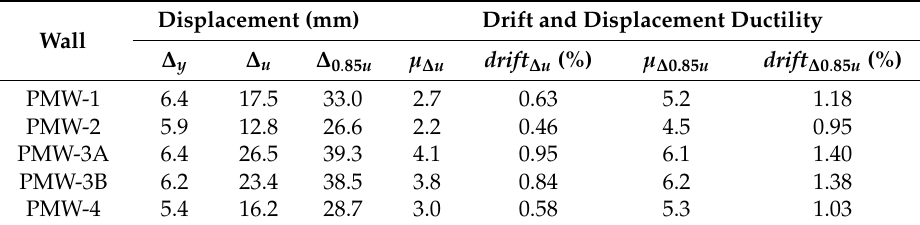
Figure 10. Theoretical yielding point of the test walls. Table 3. Summary of displacement, drift, and ductility of PRMSW specimens.